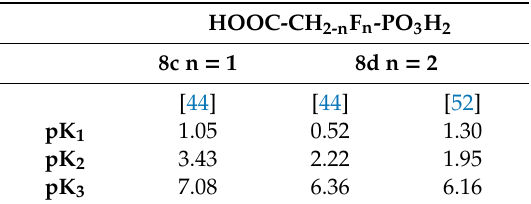
8c 2- n F n -PO 3 H 2 (